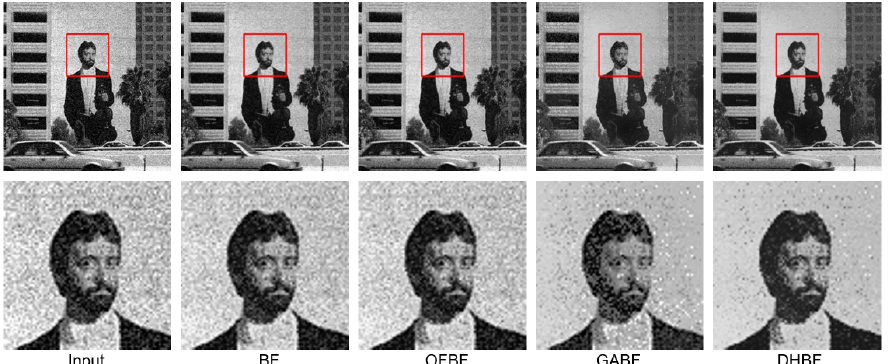
Figure 7. Visual comparison of the representative sample for image smoothing on